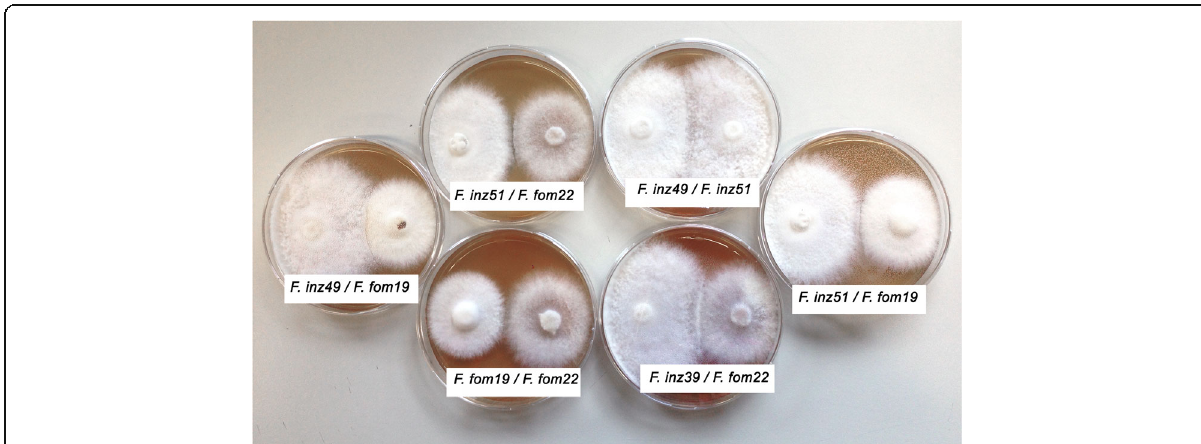
Fig. 7 Confrontations test of different isolates of Fomes fomentarius and F. inzengae after 6 d on MEA 3% at 25 ° C. fomes inzengae is always growing faster and with a fluffier surface. F. inz49 = F. inzengae (IB20160349), F. inz51 = F. inzengae (IB20160351), F. fom19 = F. fomentarius (IB20130019), F. fom22 = F. fomentarius (IB20130022)